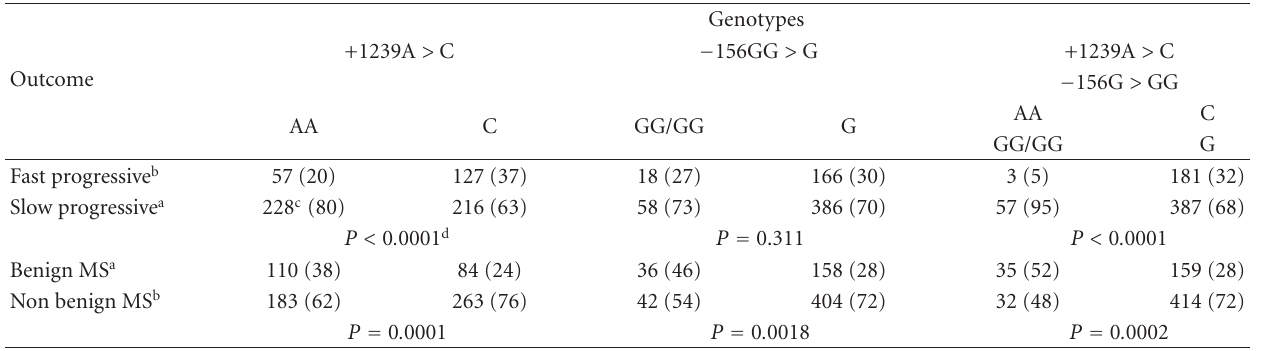
Table 3: Frequency distribution of di ff erent outcomes in MS patients carrying di ff erent OPN genotypes.